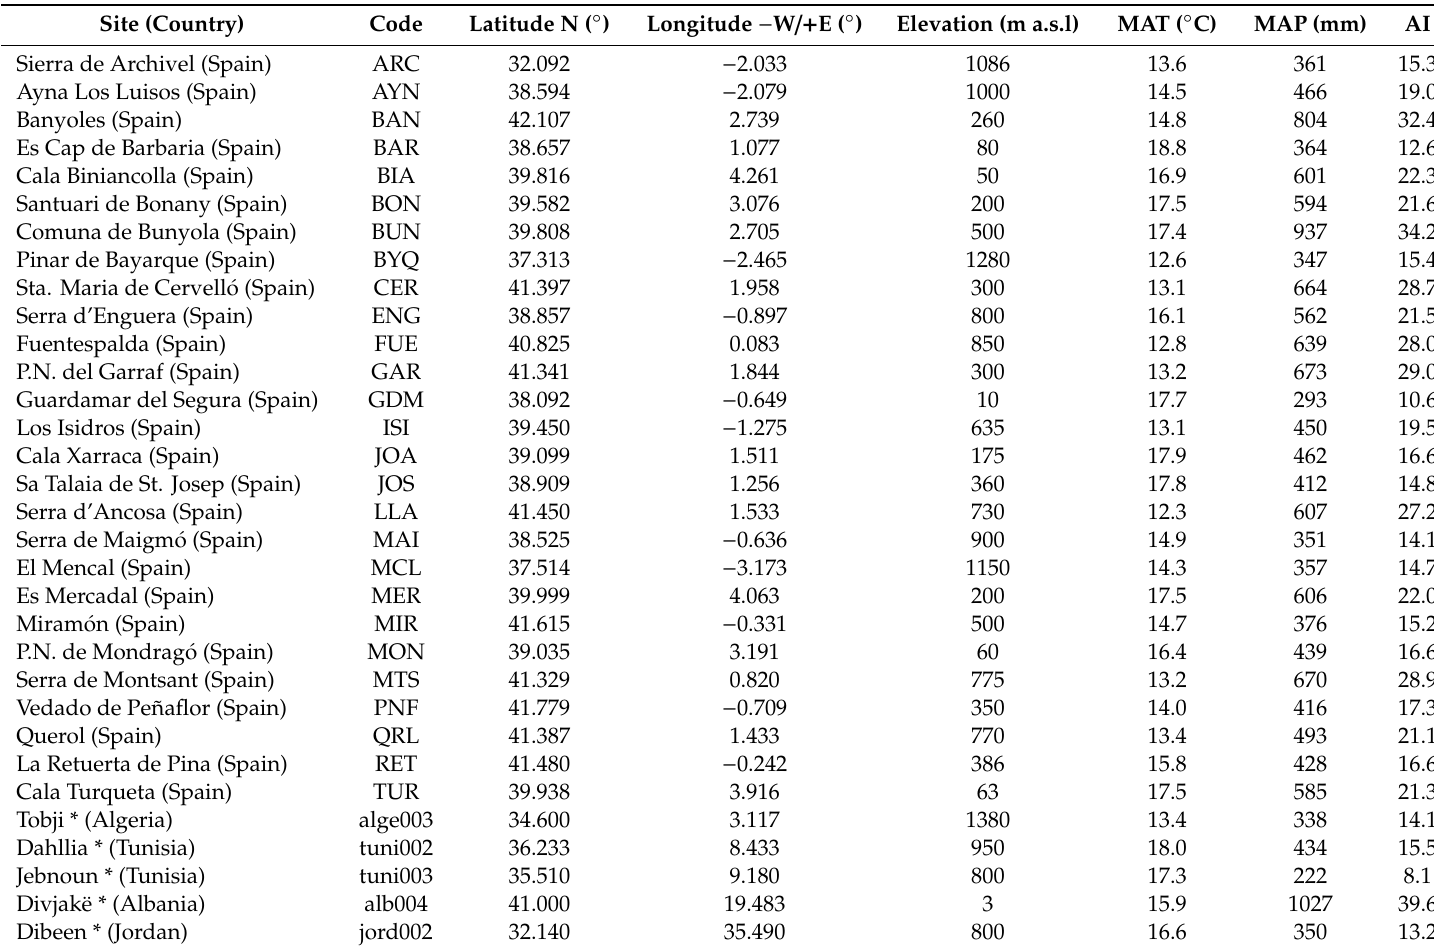
Table 2. Characteristics of the Aleppo pine study sites. Variables’ abbreviations: MAT, mean annual temperature; MAP, mean annual precipitation; AI, De Martonne aridity index. * ITRDB sites